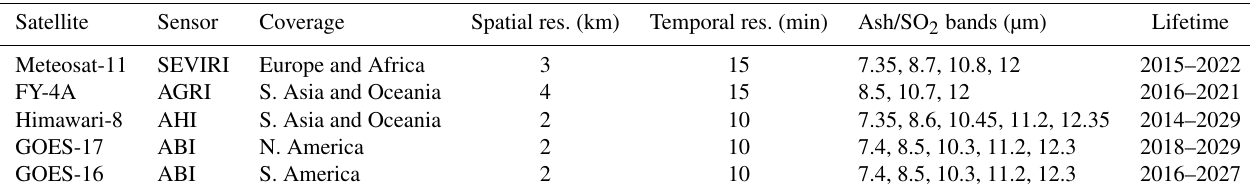
Table 7. Characteristics of sensors for ash and SO 2 detection aboard the new generation of geostationary satellites. Table courtesy of Andrew